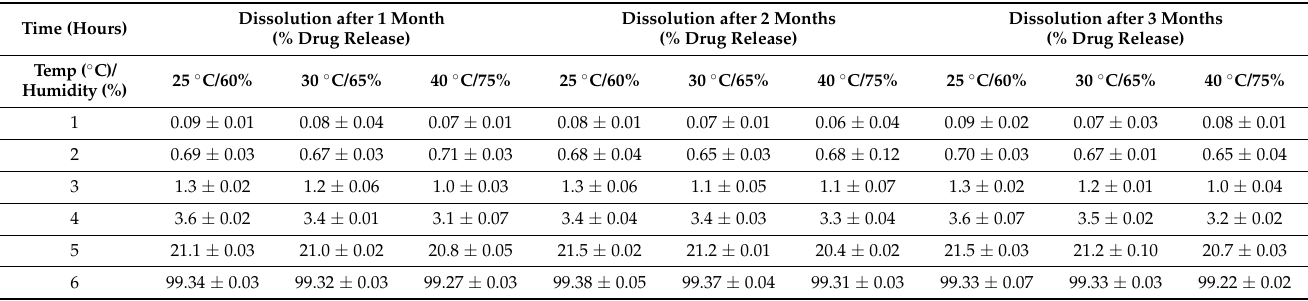
Figure 6. The in vitro dissolution of formulation E1 to E6 (the first 2 h in an acidic medium of pH 1.2, then in a phosphate buffer medium of pH 6.8) prepared after modifying the formulation of D6. The E6 formulation showed promising drug release, as required. Table 10. Stability studies of the E6 formulation under different temperatures and humidity condi- tions (n =